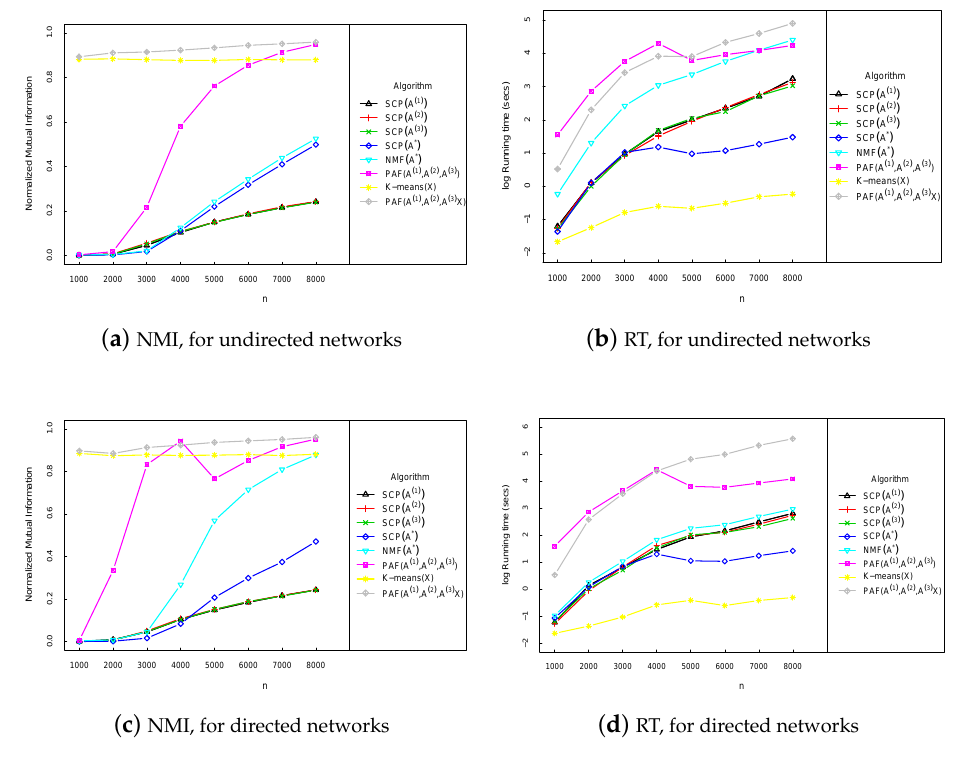
Figure A1. The left two panels present the NMI results for Setting V and the right two panels present the RT (running time in log-second) results for Setting